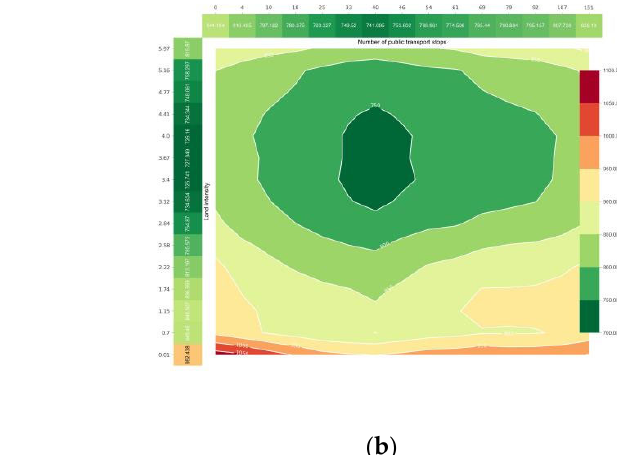
Figure 9. Synergistic effects of land-use indicators on commuting CO 2 emissions. ( a ) Synergy of land use entropy and land use intensity; ( b ) Synergy of road density and land use intensity.